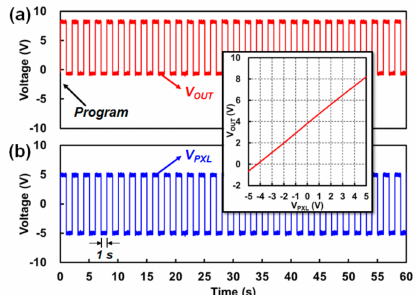
Figure 9. ( a ) Measured output of the source follower. ( b ) Converted pixel voltage using a voltage transfer characteristic (inset). The circuit worked for 60 s after programming